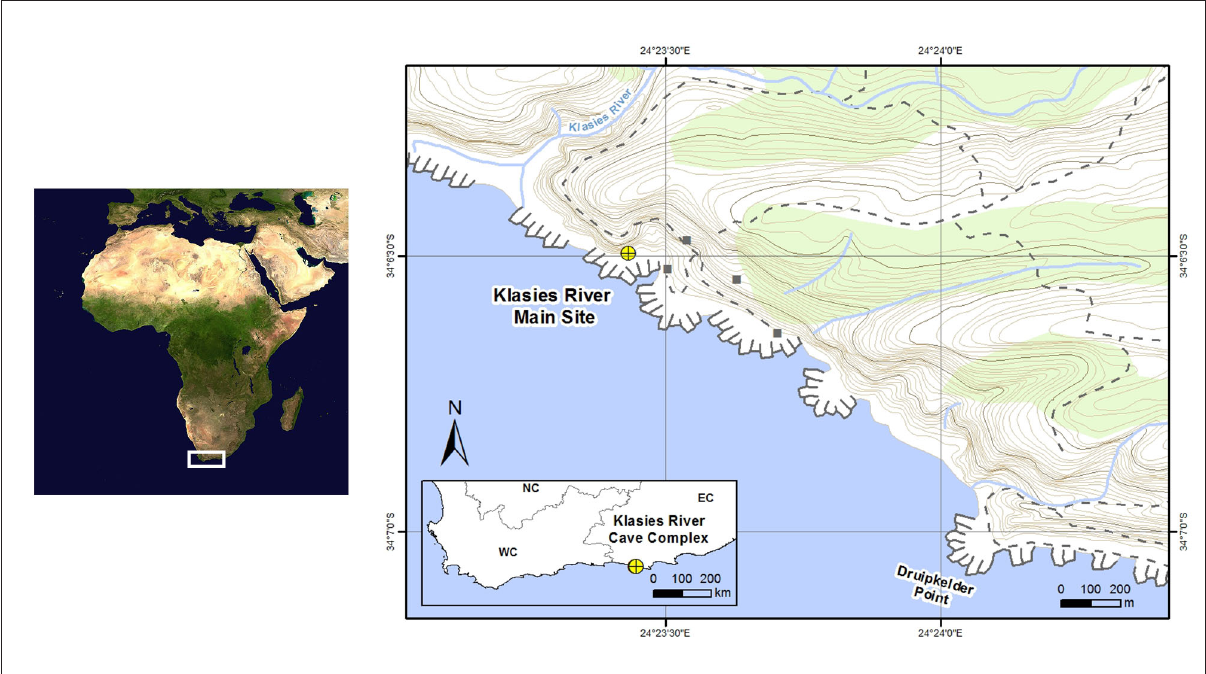
Figure 1: Location of Klasies River sites in South Africa (34°06.30’S;